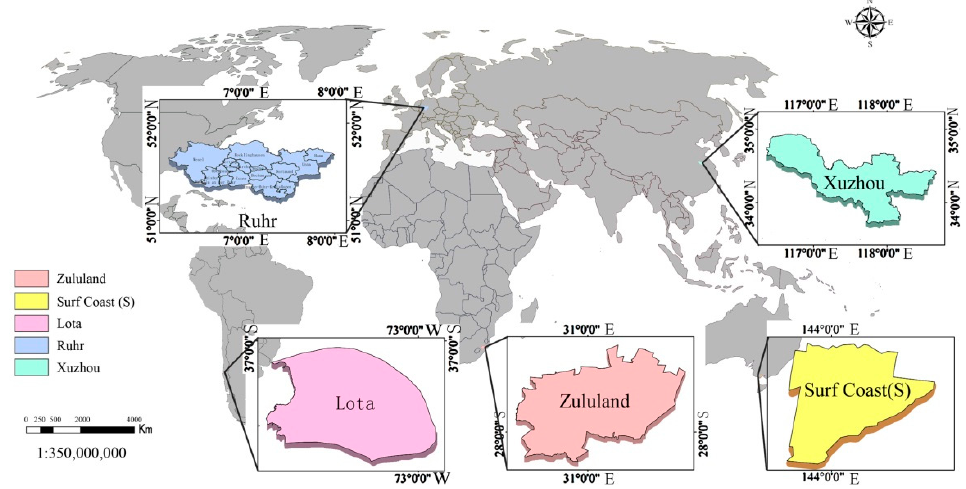
Figure 1. The geographical location and administrative divisions of five selected resource-based urbans (Zululand in South Africa, Xuzhou in China, Lota in Chile, Surf Coast in Australia, Ruhr in Germany).